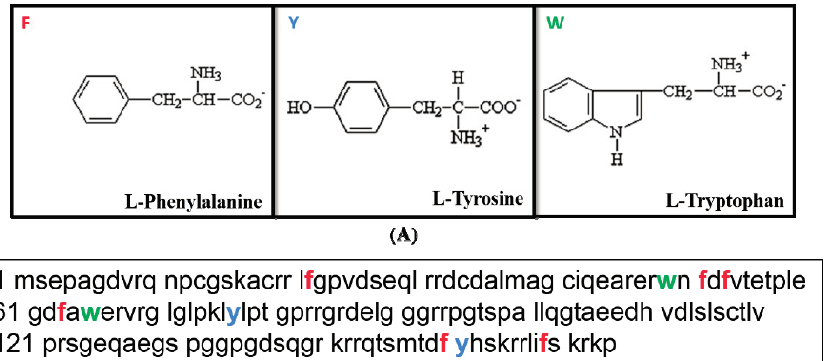
Figure 3. Tertiary sequence of p21. ( A ) Structure of the three aromatic acids, i.e. , Phe, Tyr and Trp. Phe contains only hydrophobic group whereas Tyr and Trp have both hydrophobic and hydrophilic side groups. ( B ) Relative frequency of the three aromatic amino acids in the p21 primary structure, i.e. , Phenylalanine/Phe/F (in red) is at number of 6,